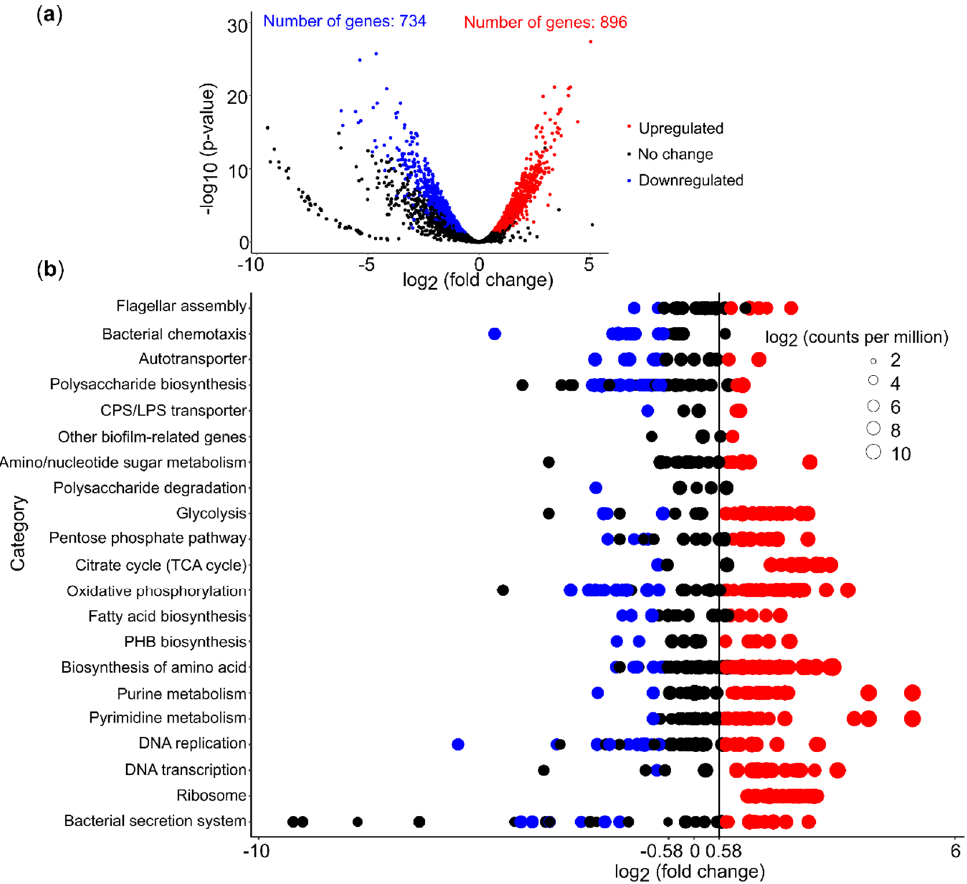
Figure 5. Differential gene expression profiling of Acidiphilium sp. C61 upon PEA (10 µM) supplementation. (a) Volcano plot of differentially expressed genes (DEGs) with statistical significance and fold change in the control and treatment group. Significantly differentially expressed genes are defined by a log 2 FC (log 2 fold change) > 0.58 or log 2 FC < –0.58, log 2 counts per million (log 2 CPM) > 6, and an adjusted p -value FDR (false discovery rate) < 0.05. Each dot represents a single expressed gene. Red dots represent upregulated genes, blue dots represent downregulated genes, and black dots represent genes not upregulated or downregulated. (b) Gene expression patterns of selected KEGG pathways in Acidiphilium sp. C61 incubations with 10 µM PEA. Each bubble denotes one gene and the bubble size indicates log 2 CPM values. Red and blue bubbles represent up- and downregulated genes, while black bubbles represent non-significantly differentially expressed.